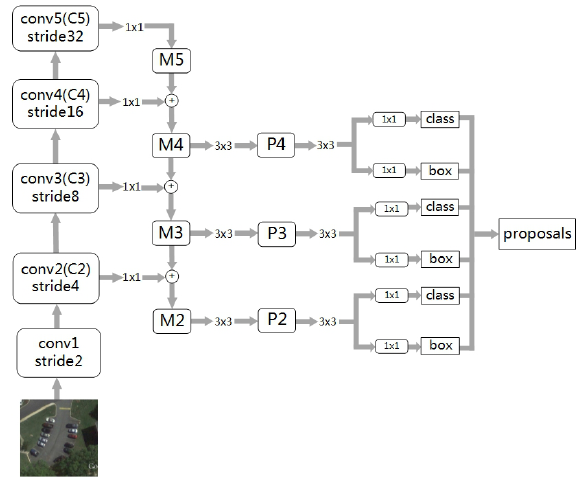
Figure 3. Illustration of our vehicle detection module(VDM). Bottom-up feature extraction and top-down multiscale feature fusion for region proposal generation. M5, M4, M3, M2 indicate the middle levels of intermediate operation. P4, P3, P2 indicate the pyramid levels. 1 × 1 and 3 × 3 represent the convolution layer with kernel size 1 and 3